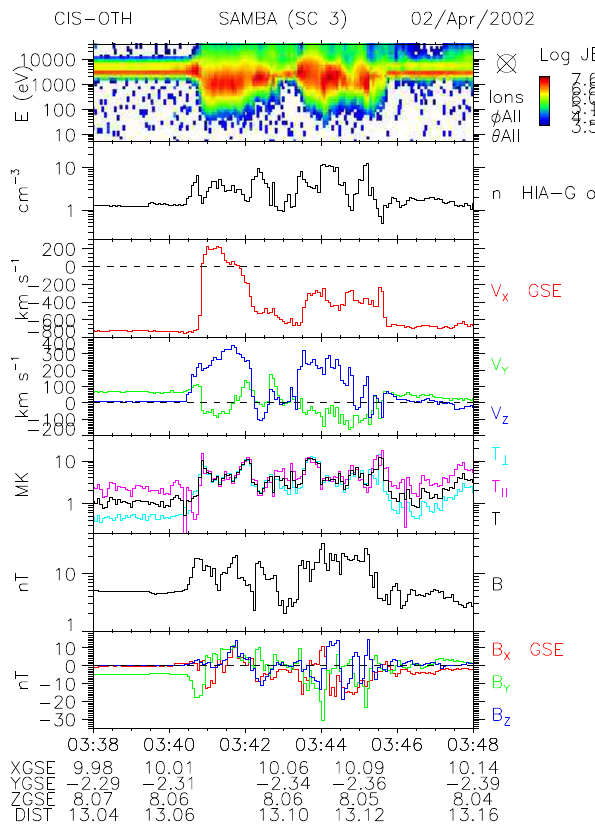
Fig. 1. Hot flow anomaly, 2 April 2002, summary; spin-resolution all-ion spectrogram and moments from CIS/HIA, and magnetic field vectors from FGM (cf. Lucek et al.,